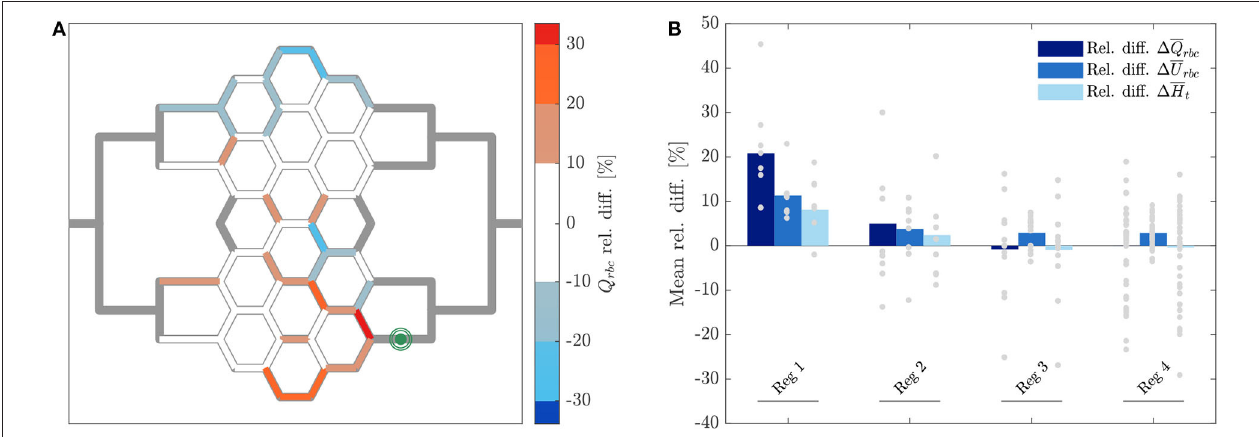
FIGURE 7 | RBC flux relative difference for pericyte activation. (A) Relative RBC flux difference for individual micro-channels of the honeycomb network between the inflation of the pressure chamber ( 1 P 9.8 mbar , p 2.25 bar ) and the control case ( 1 P 9.8 mbar , p 0 bar ). The green symbol indicates the activated = = = = micro-channel. Flow direction is from left to right. (B) Mean hematocrit, RBC velocity, and RBC flux relative differences due to the activated branch different regions defined in Figure 2